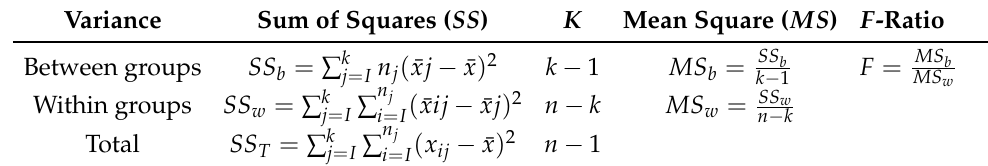
Table 1. One-way ANOVA [16].